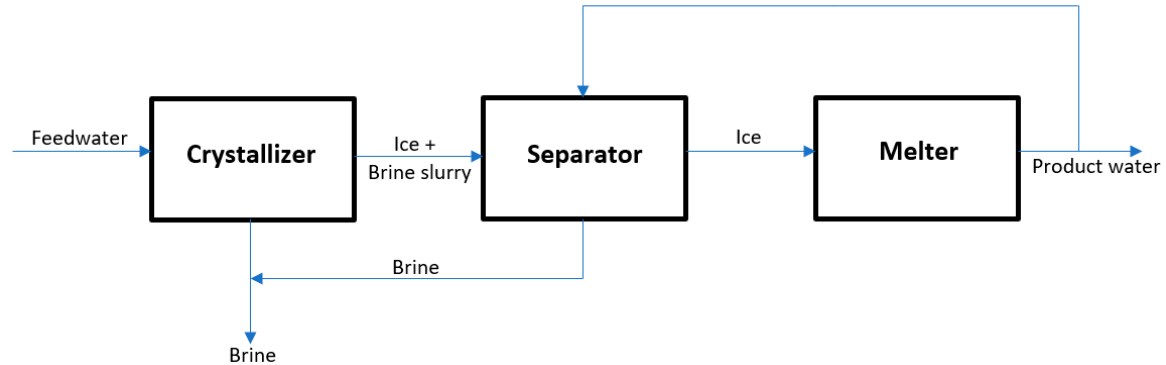
Figure 2. Schematics of the freeze concentration process.